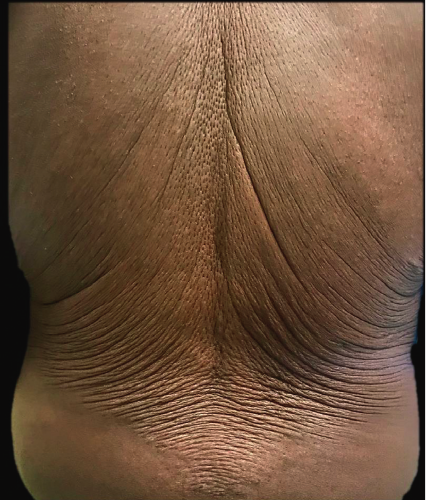
Figure 2: Back with evident loose, wrinkly, redundant skin folds.